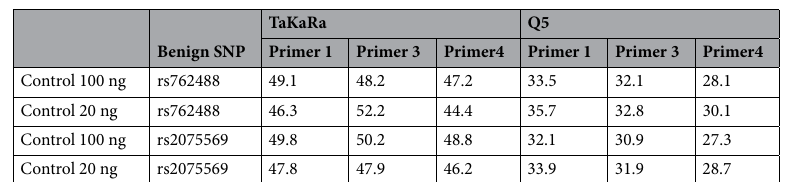
Table 1. Variant frequencies based on DNA input of 20 ng and 100 ng of commercial human control samples. 4 ng was not sequenced due to a low